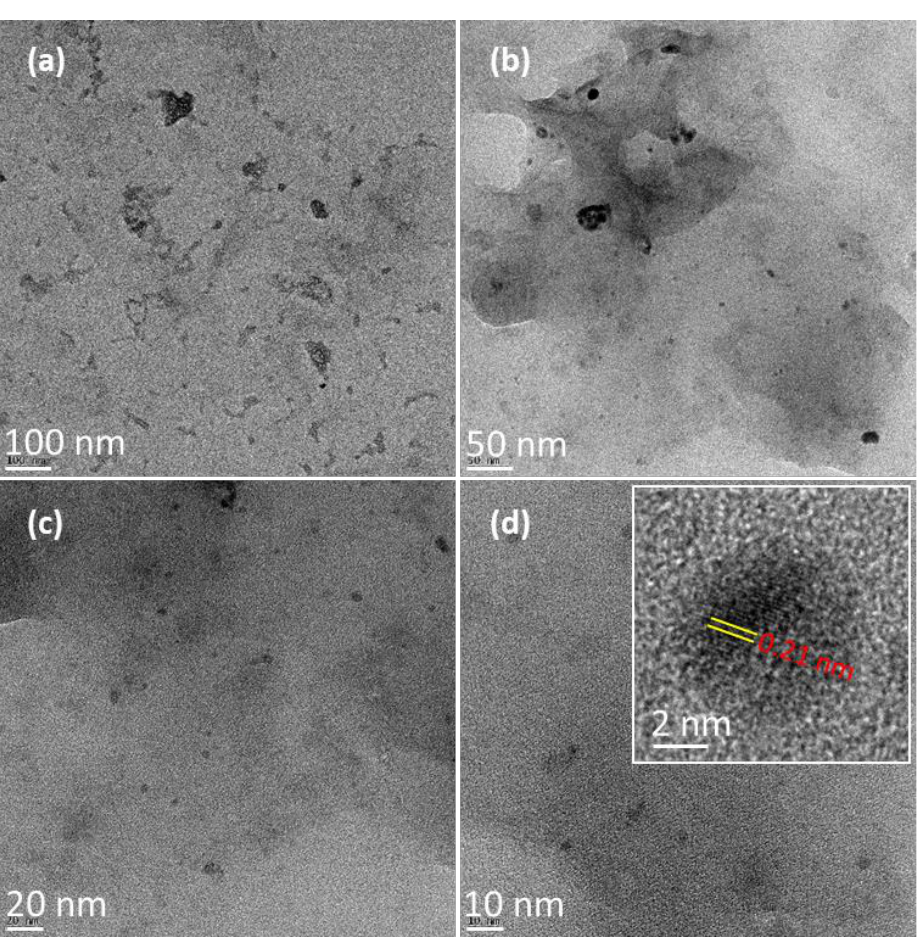
Figure 2. ( a – d ) TEM/HRTEM images with different magnifications of P-CDs synthesized from